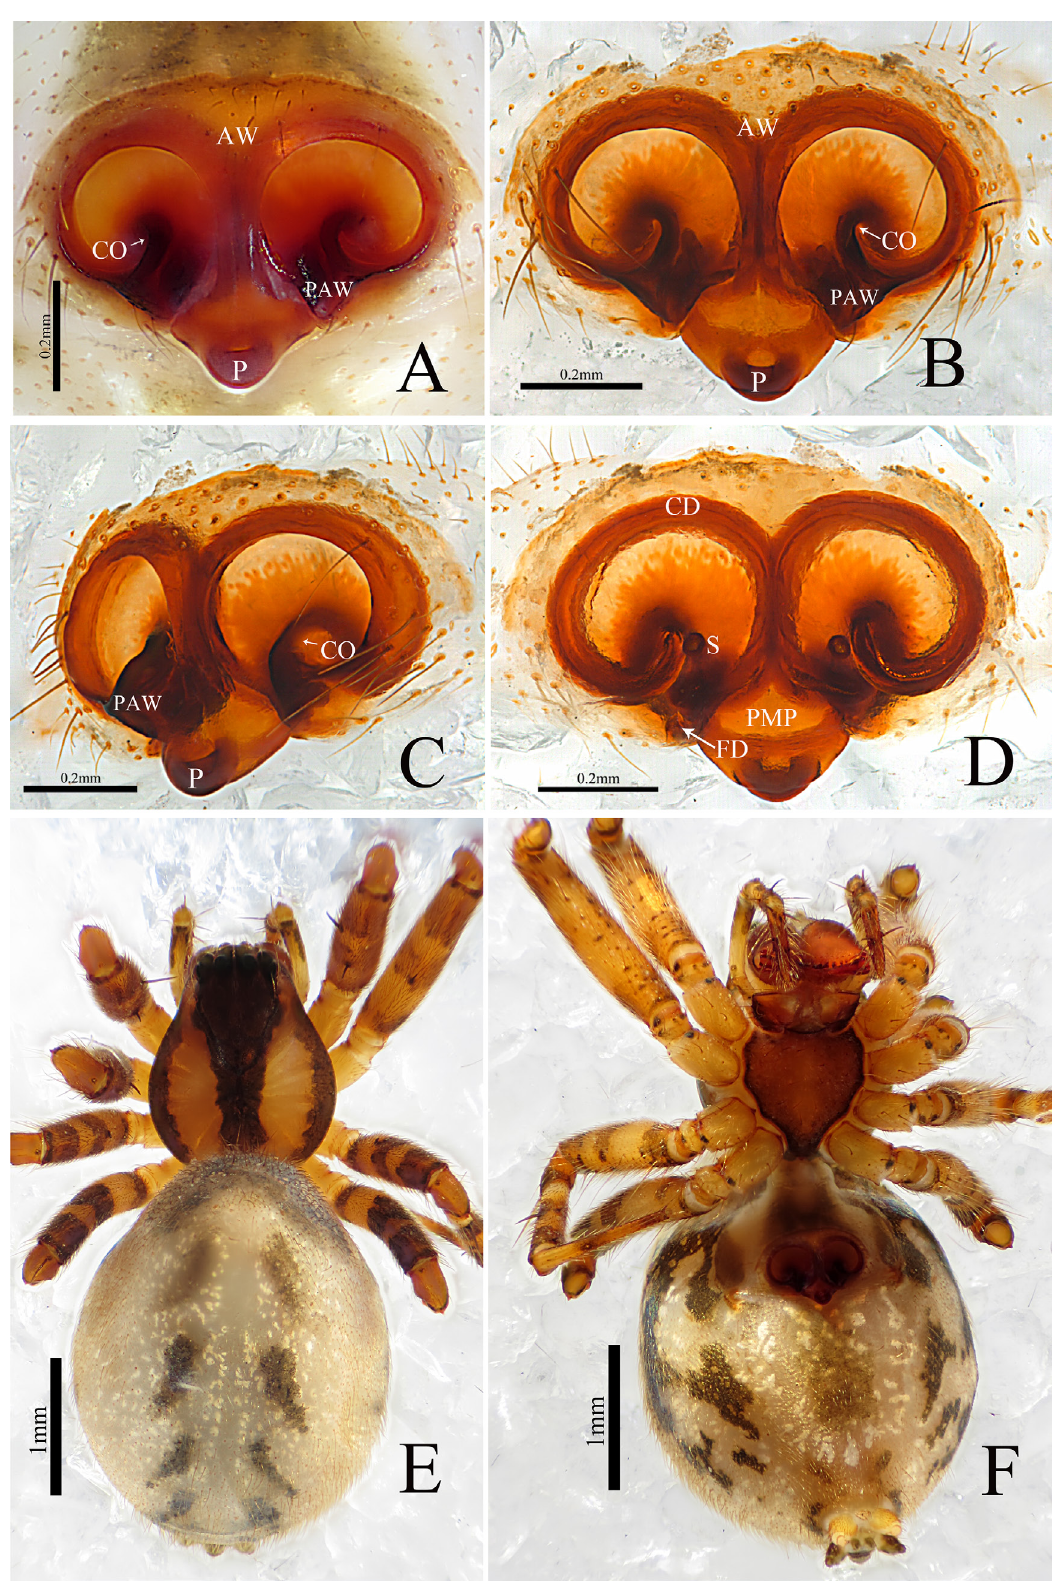
Fig. 37. Acroterius parvus gen. et sp. nov., ♀, holotype (HNU-Hu060819). A–B . Epigyne, ventral view. C . Epigyne, lateral view. D . Vulva, dorsal view. E . Habitus, dorsal view. F . Habitus,